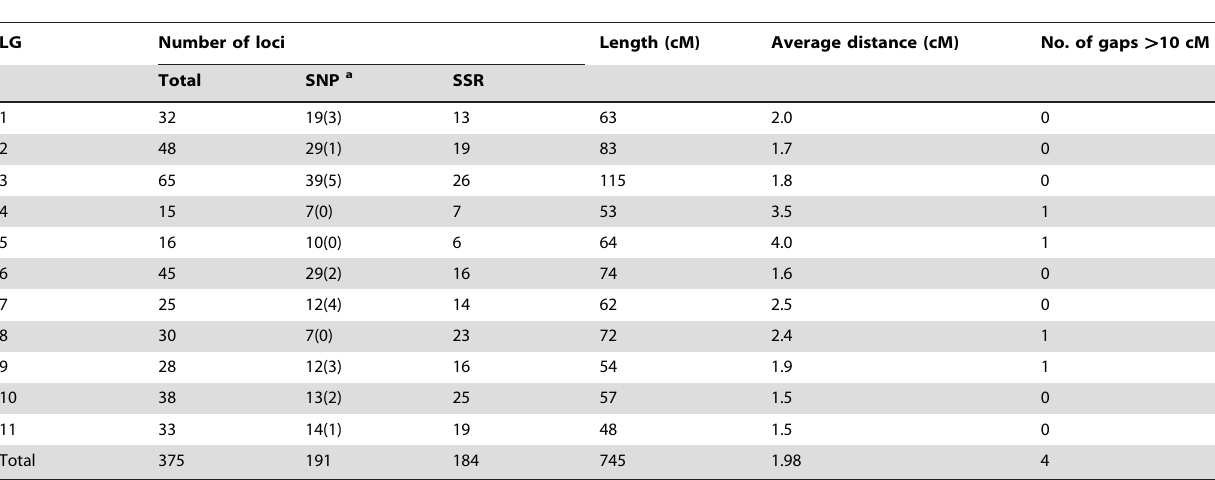
Table 2. Marker distribution on the 11 linkage groups of asparagus bean.